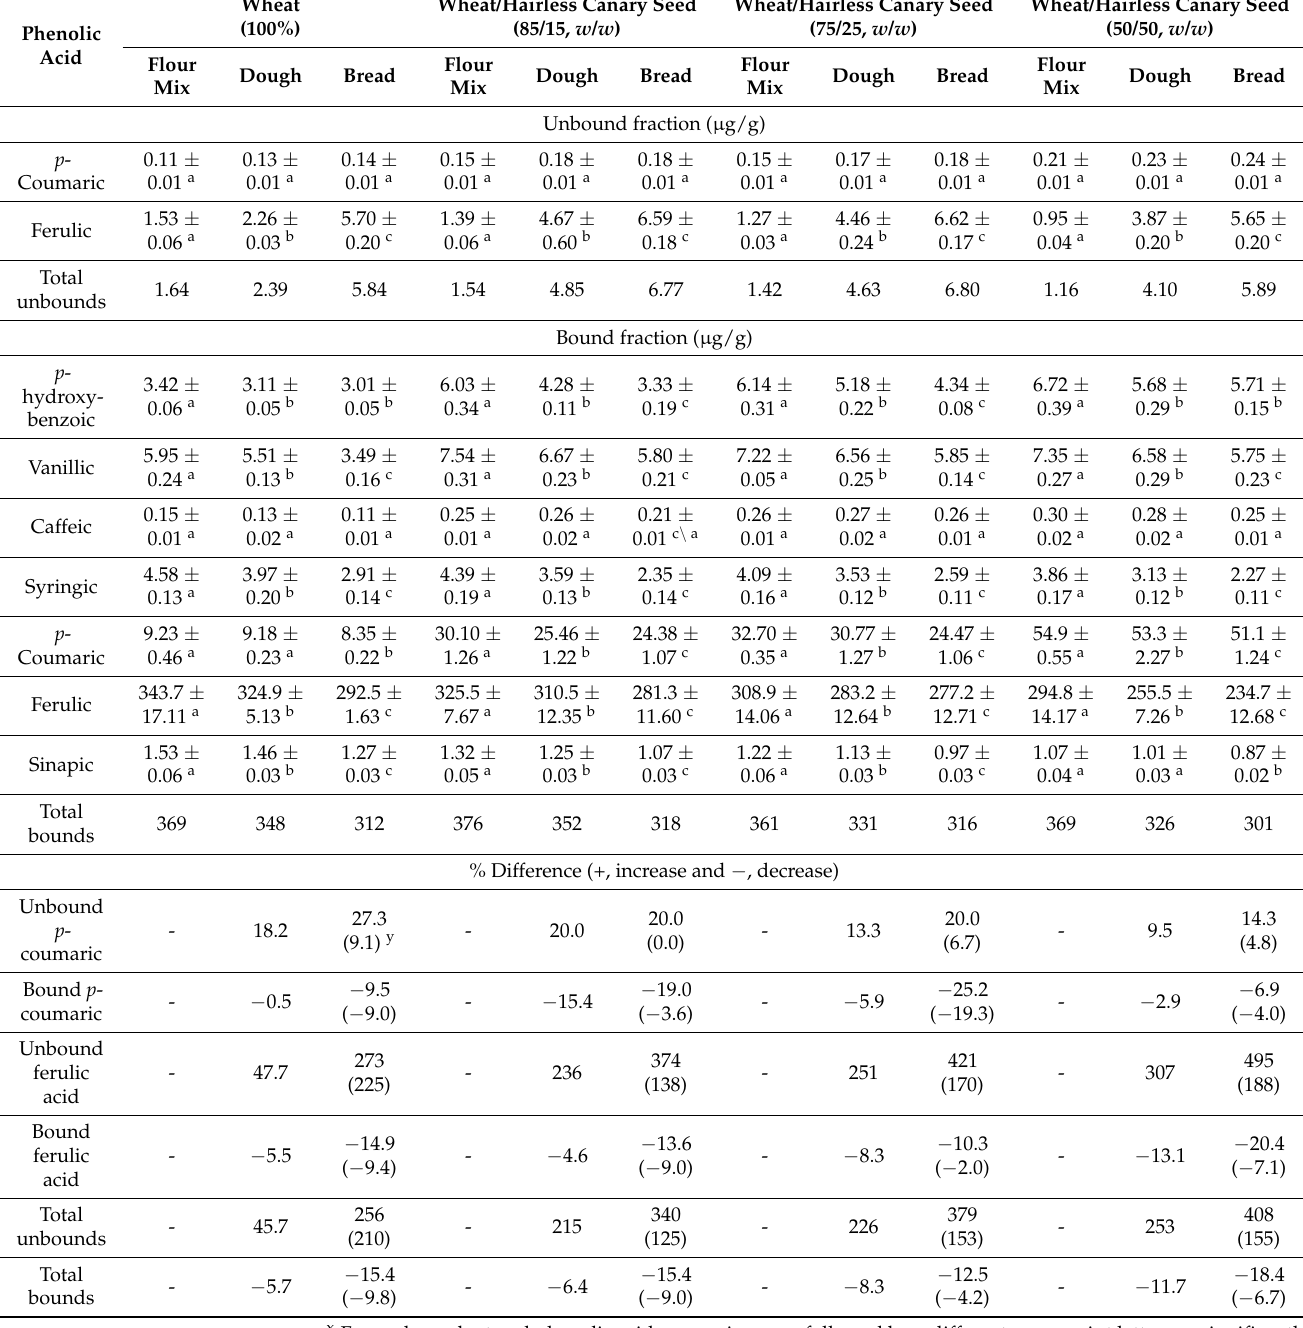
Table 2. Composition of unbound and bound phenolic acids of dry flour mix, dough, and fresh bread products and the impact of baking process on their concentrations x